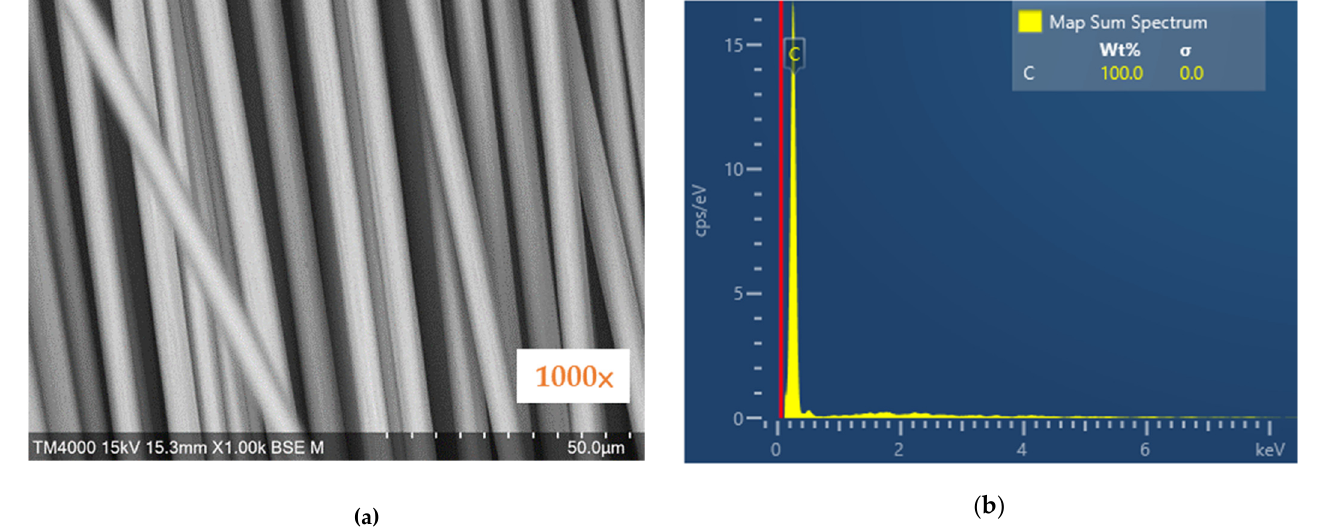
Figure 5. SEM observation of carbon fiber by removal of coupling agent: ( a ) SEM image; ( b ) EDX graph.